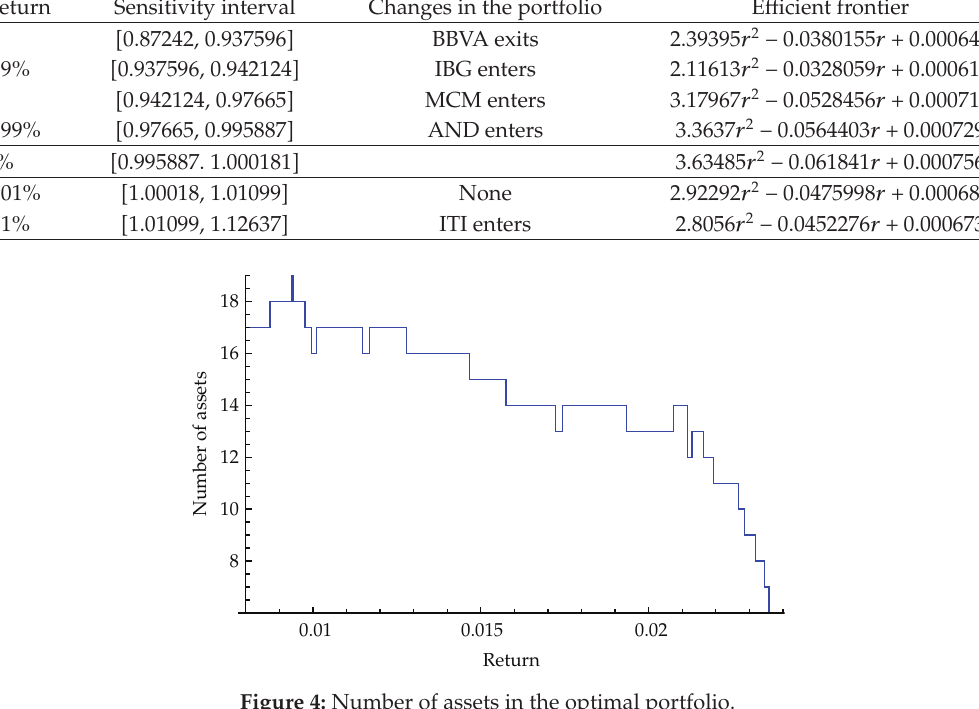
Figure 4: Number of assets in the optimal